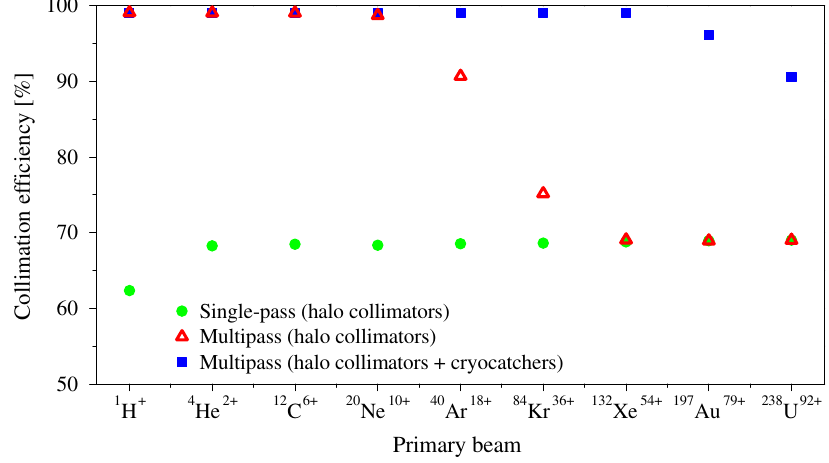
FIG. 7. Collimation efficiency calculated for various primary beams from proton up to uranium in